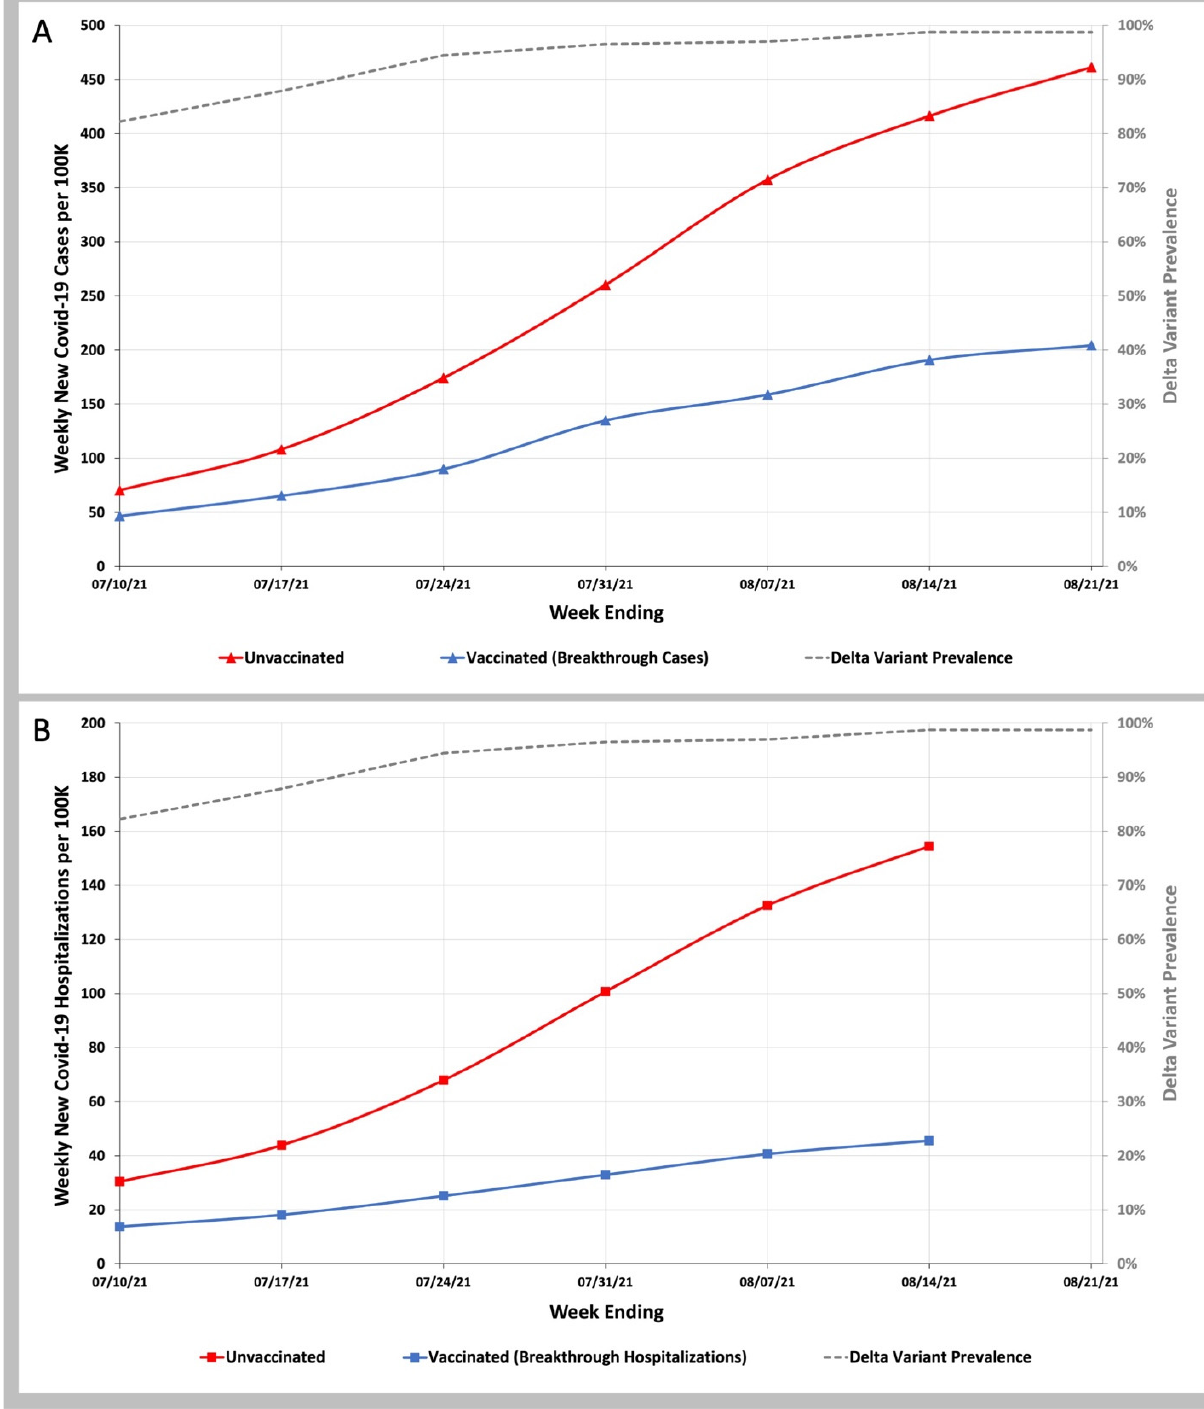
Figure 1. COVID-19 Infection and Hospitalization Rates in Vaccinated and Unvaccinated Individuals during the Delta Variant Phase of the Pandemic. ( A )—Weekly infection rates per 100 K vaccinated (blue line) and unvaccinated (red line) individuals. ( B )—Weekly hospitalization rates per 100 K vaccinated (blue line) and unvaccinated (red line) individuals. Weekly SARS-CoV-2 Delta variant prevalence reported by the CDC (gray dashed line).